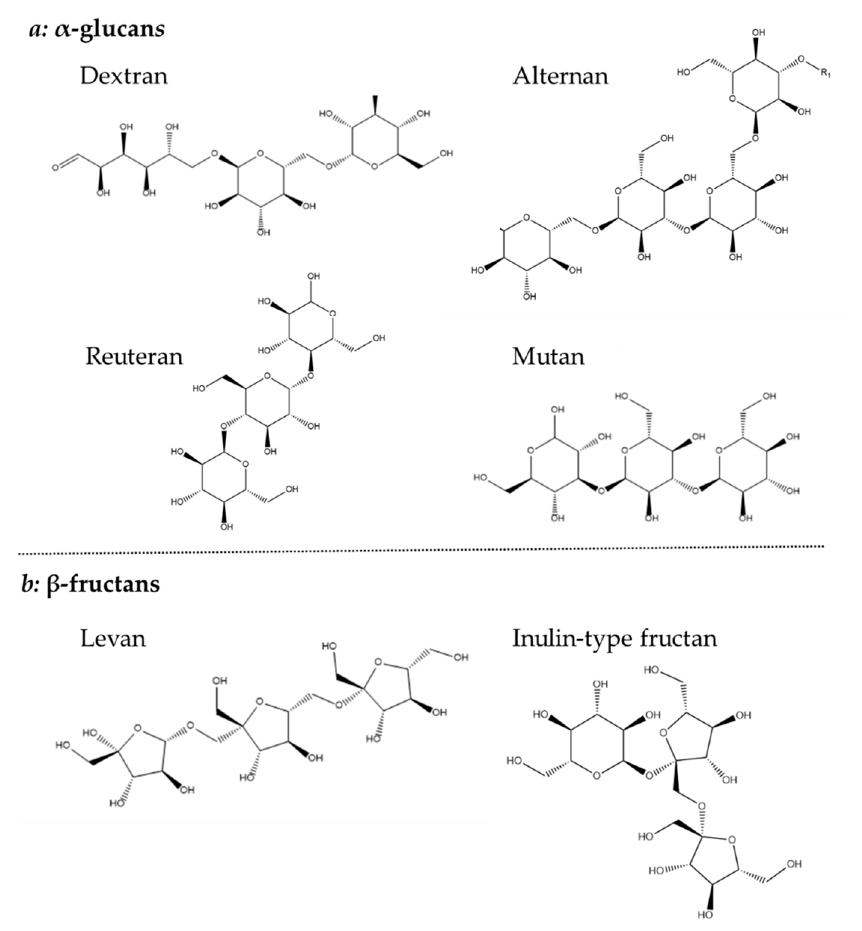
Figure 4. Chemical structure of ( a ) α -glucans and ( b ) β